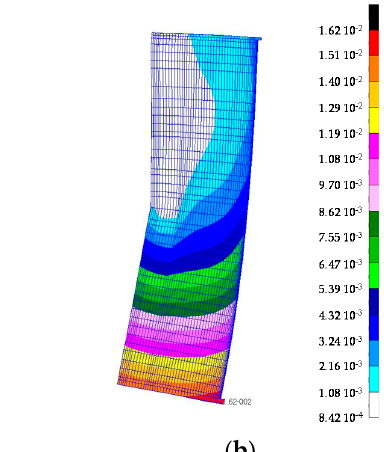
Table 4. FE results: the structure stiffness comparison in the X , Y , and Z directions.